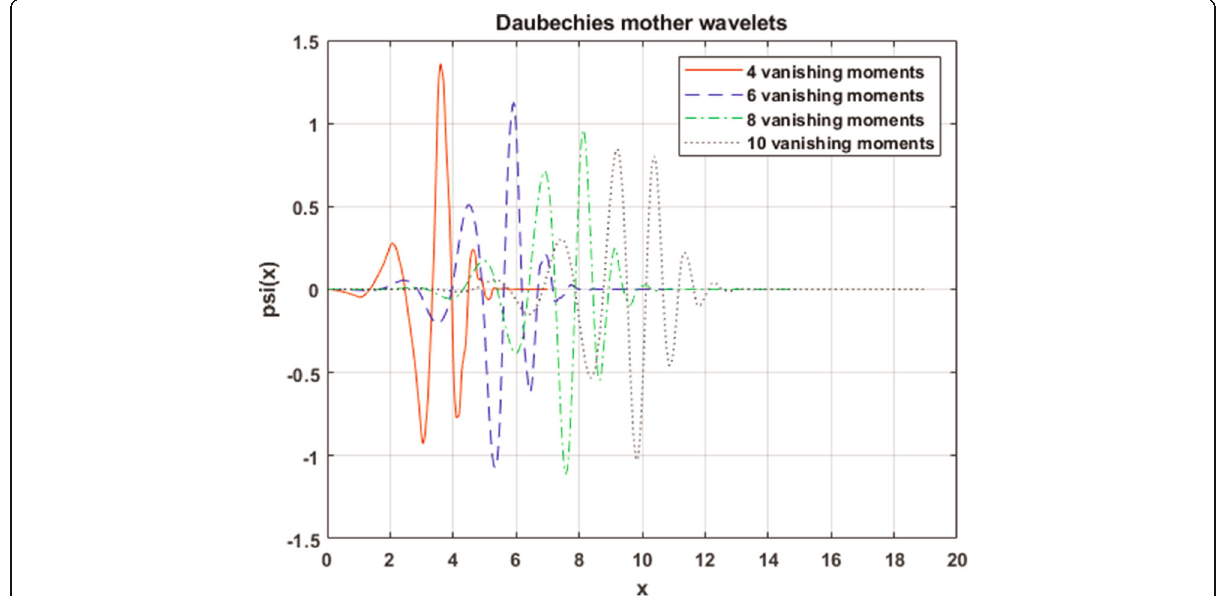
Fig. 2 Daubechies wavelets with different vanishing